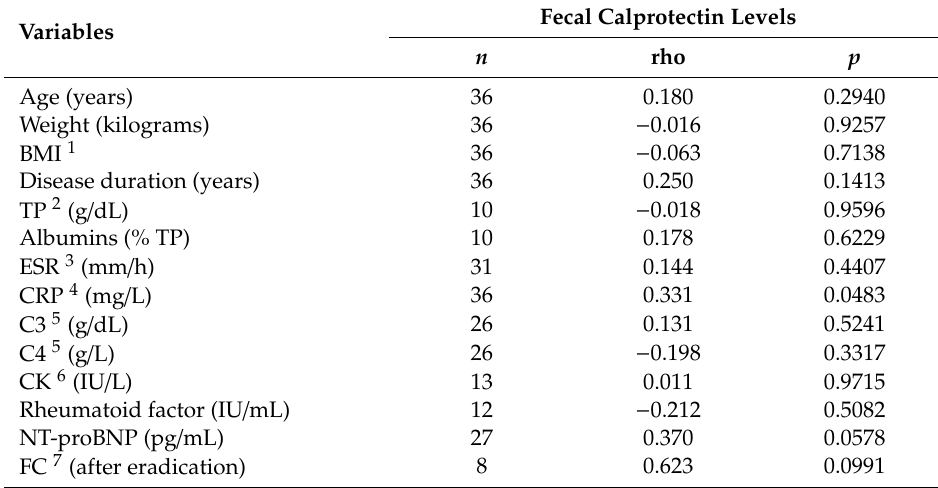
Table 3. Spearman;s rank correlations of fecal calprotectin levels and selected demographic, clinical, and biochemical